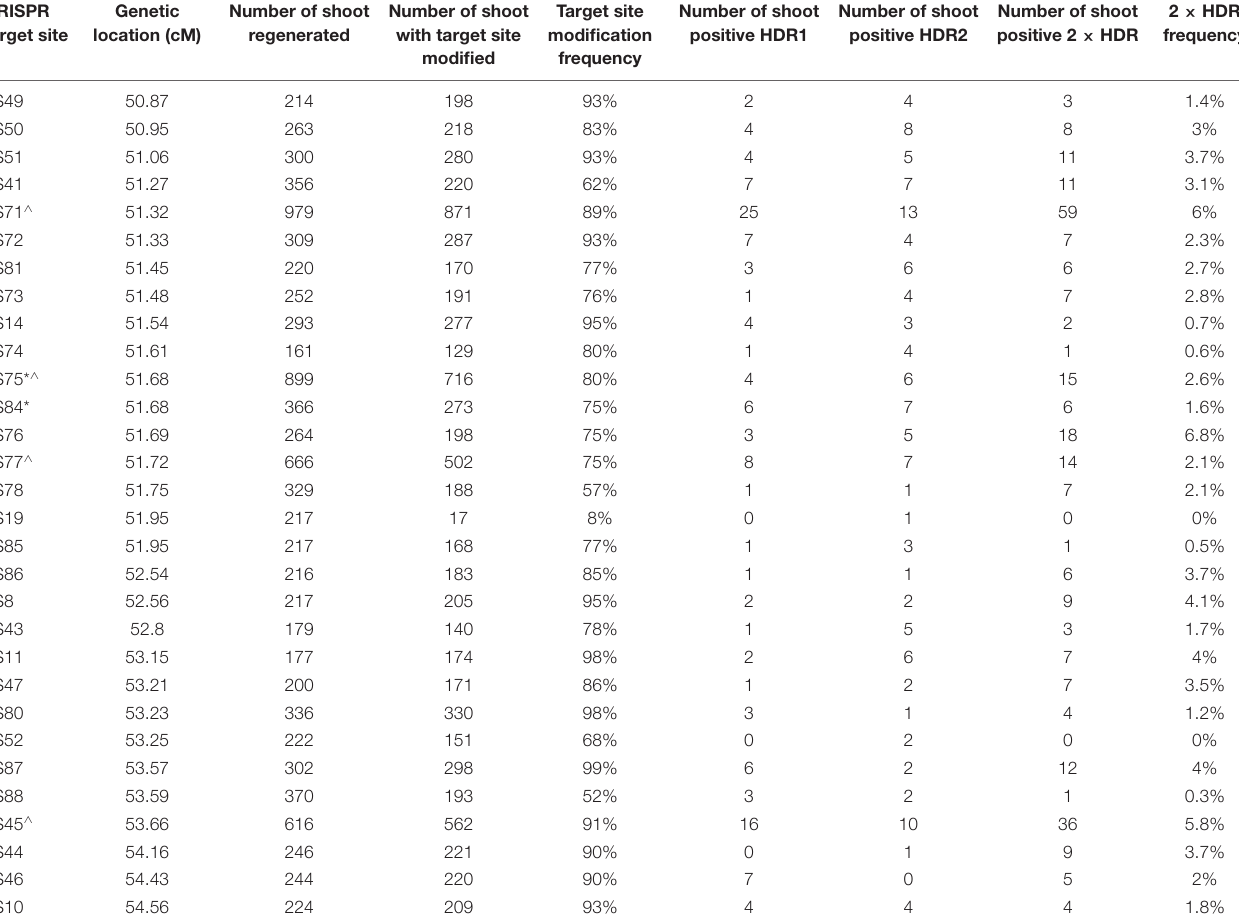
TABLE 1 | CRISPR-Cas9 mediated insertion of SSILP in preselected sites at CTL1 in PH184C. CRISPR Genetic target site location